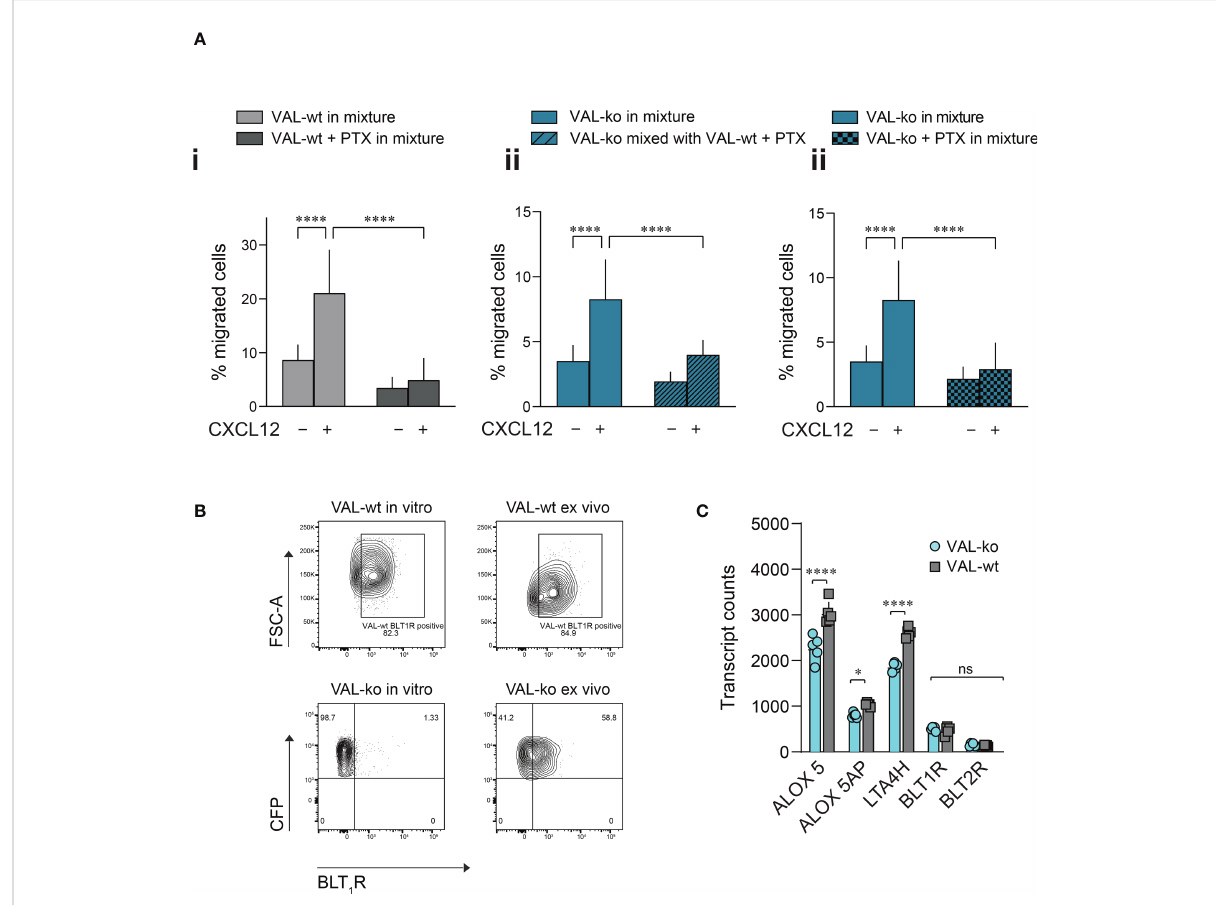
FIGURE 5 VAL-ko migration in the presence of VAL-wt is PTX sensitive. (A) Transmigration towards 10 nM CXCL12 was performed and calculated as described in Figure 1. (i) VAL-wt untreated (light grey) or treated with PTX (dark grey) in the mixture with untreated VAL-ko. (ii) VAL-ko mixed with untreated (left, plain bars) or PTX-treated VAL-wt (right, hatched bars). (iii) VAL-ko untreated (left, plain bars) or PTX-treated (right, hatched bars) mixed with untreated VAL-wt. Cumulative data of three independent experiments performed in triplicates (means ± SD, Turkey ’ s multiple comparisons test, ONE WAY ANOVA, ****p ≤ 0.0001). (B) BLT1R (mAb 203/14F11) surface expression on VAL-wt (upper panels) and VAL-ko (lower panel) cultured in vitro (left panels) or ex vivo (right panels). Representative plots of three different fl ow cytometry analyses. (C) Transcript levels of the lipoxygenases ALOX5 and ALOX5AP, the hydrolase LTA4H and the LTB4 receptors BLT1R and BLT2R of VAL-wt and VAL-ko (means ± SD, S ̌ ı ́ da ́ k multiple comparison, 2way ANOVA ns p ≥ 0.05, *p ≤ 0.05, ****p ≤ 0.0001) ns (not signi fi